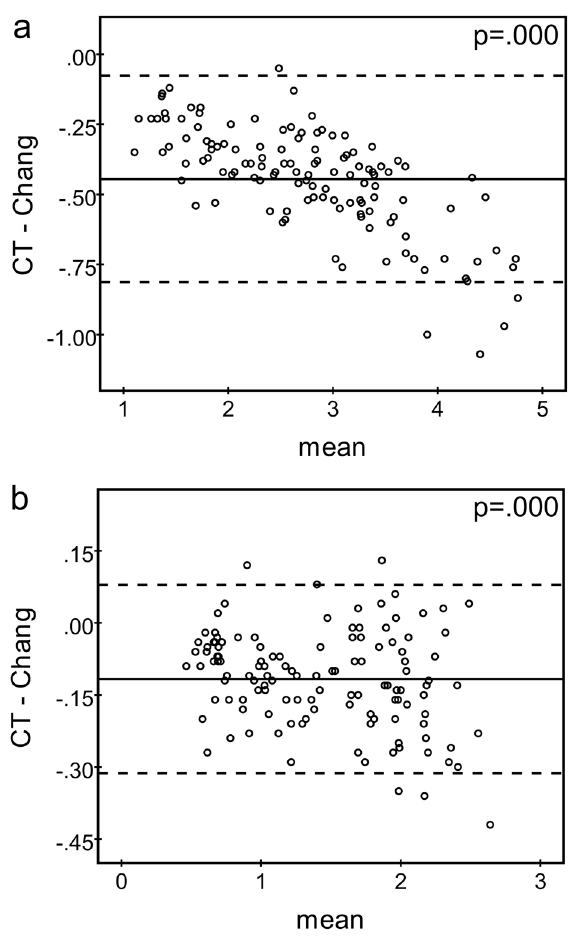
Figure 3. Bland-Altman plots comparing the SBR of the caudate (a) and the putamen (b) between CT-based and Chang AC (SBRs of both hemispheres were included independently, i.e. n=124). Different scales were chosen for abscissae and ordinates in a and b for display purposes. The horizontal continuous line represents the mean difference, the dashed lines indicate the 95% confidence interval. The given p-value corresponds to the one-sample t- test for zero mean.